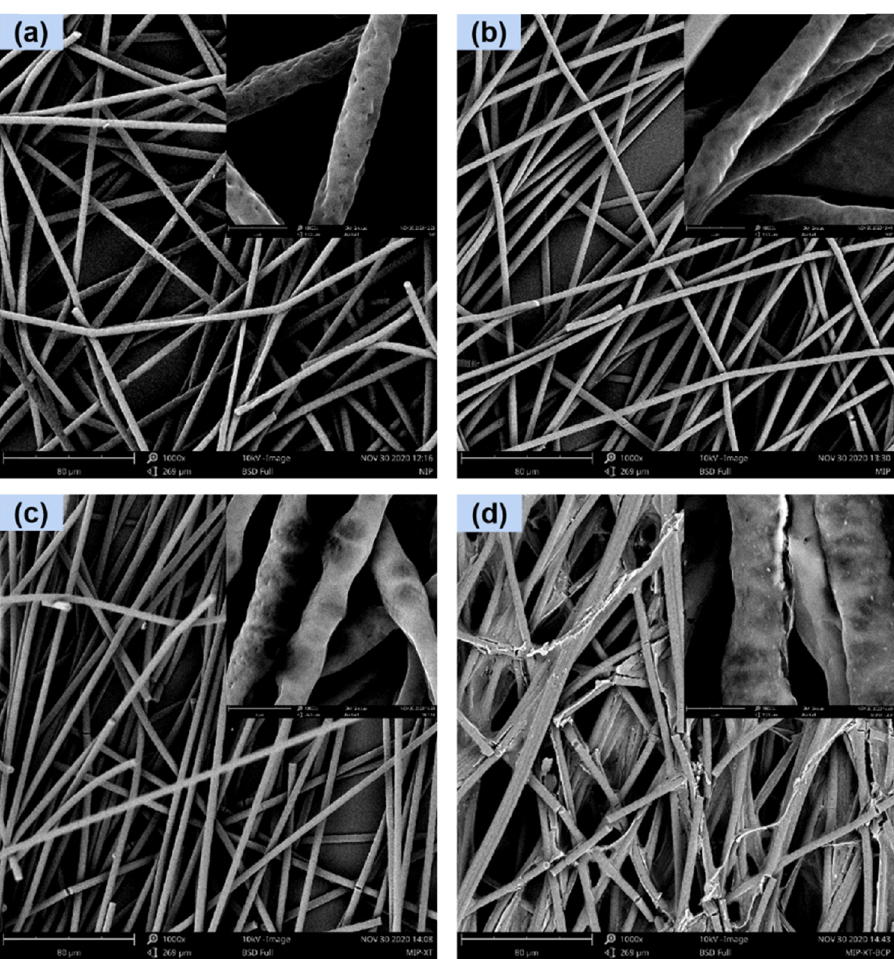
Figure 5: SEM images of the MIM in di ff erent procedures: ( a ) NIM, ( b ) MIM, ( c ) Eluted MIM, ( d ) MIM - BCP, and embedded image are the partial enlargements of sub fi gures ( a – d ) , respectively.